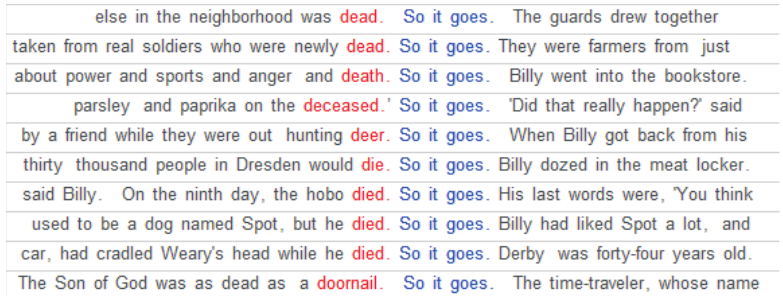
Figure 2. A fragment of concordance list for the phrase “so it goes” in Kurt Von- negut’s Slaughterhouse